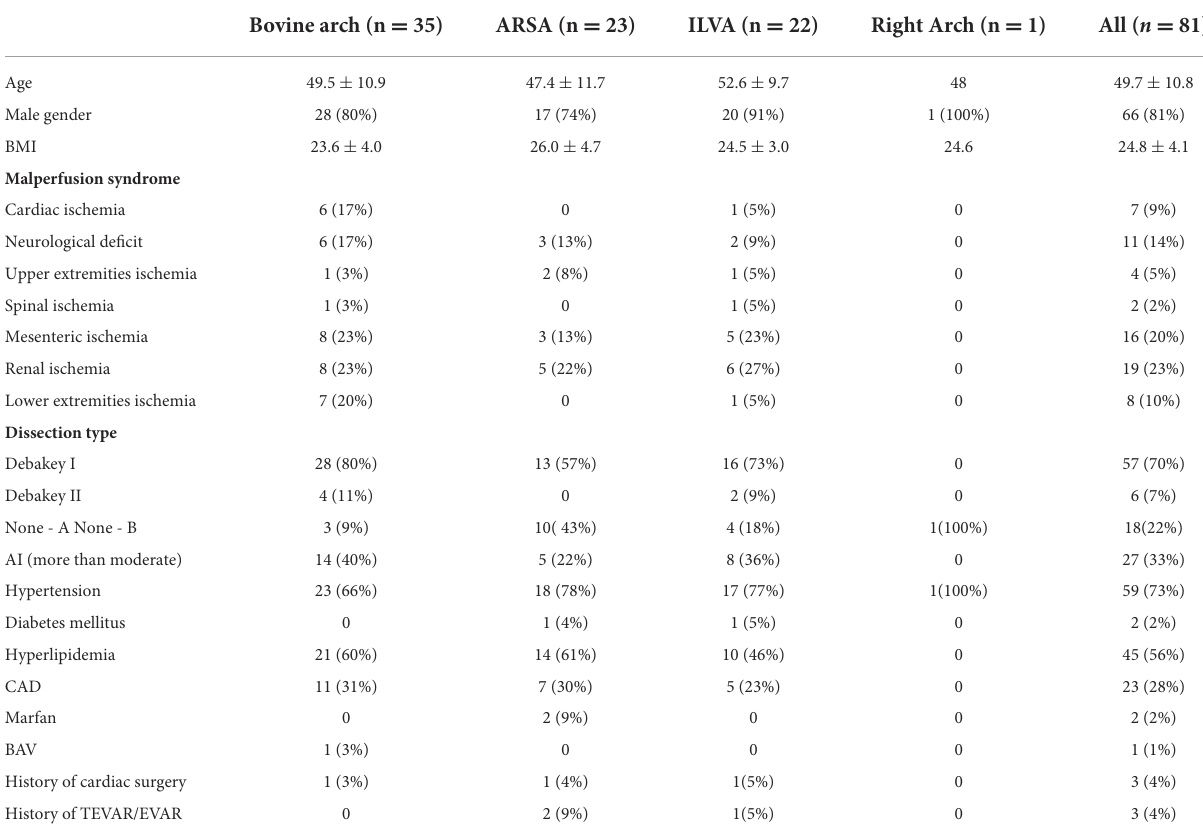
TABLE 2 Baseline